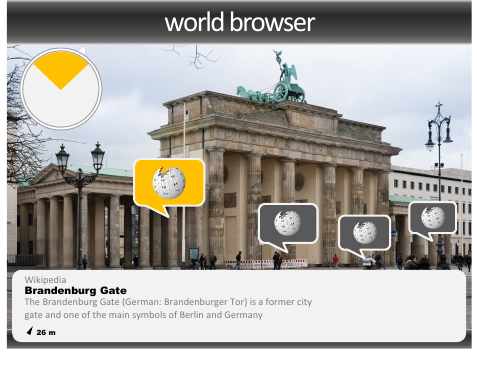
Figure 4: AR Labeling for world browsing. Exemplary appli- cation in the style of the Wikitude world browser that case, the accuracy of standard GNSS such as Galileo (around 10m) could be sufficient for defining the coarse location).